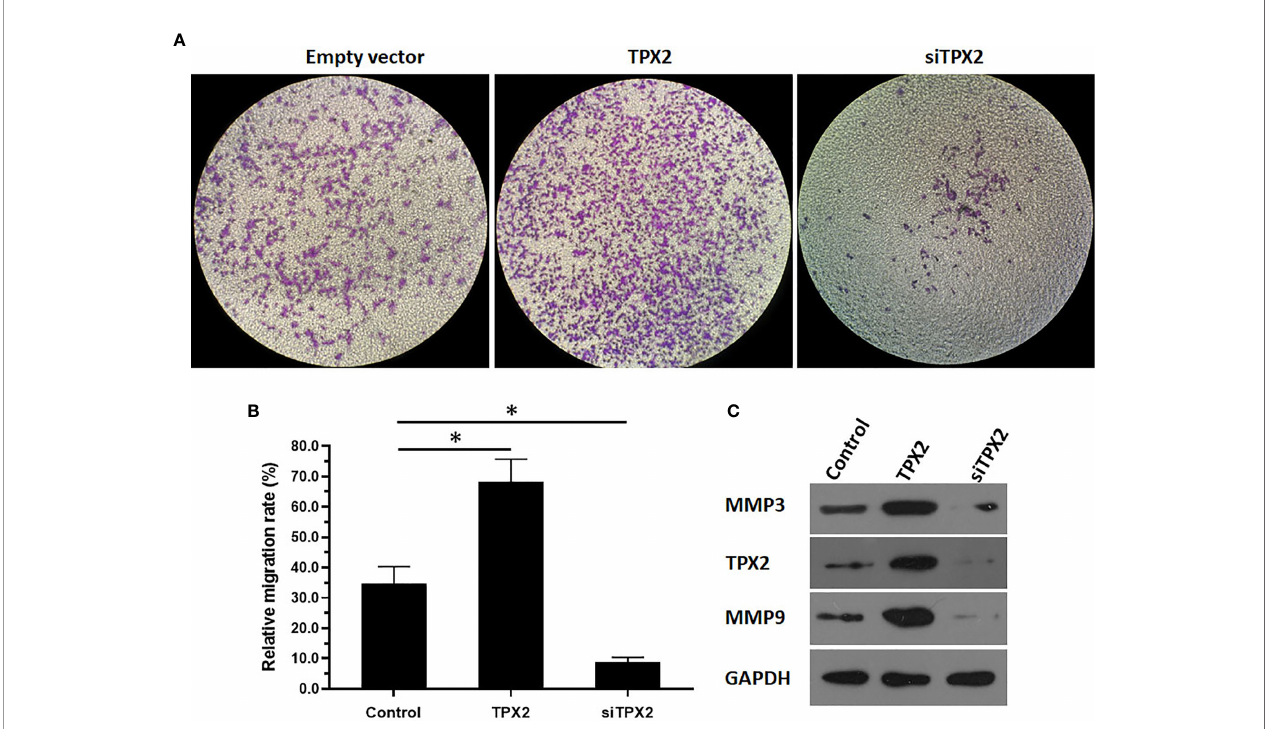
FIGURE 5 | TPX2 enhanced the in vitro invasion of PC-3 cells. PC-3 cells were transfected with the control, TPX2 or siTPX2. The cells were harvested for the transwell experiments. The results were shown as images of the invaded cells (A) or the quantitative results of the images (B) were shown. The protein level of TPX2, MMP3 or MMP9 in PC-3 cells was examined by western blot (C) .